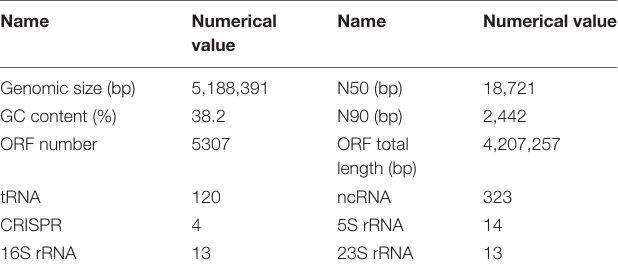
TABLE 2 | Statistics of the genomic characteristics of B. aryabhattai SK1-7. TABLE 3 | Statistics of the genomic characteristics of B. aryabhattai SK1-7.